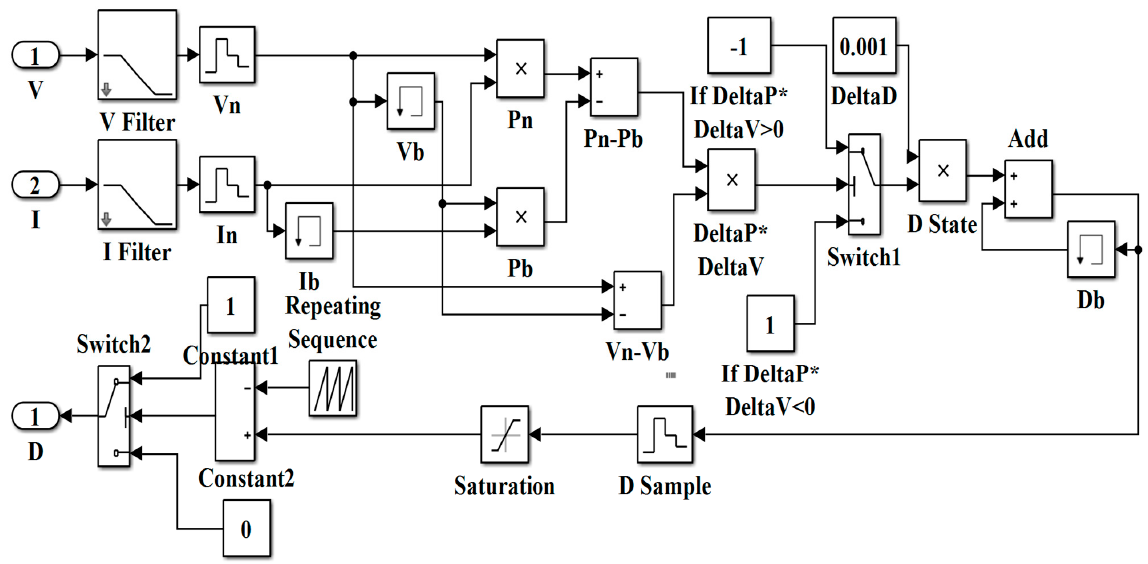
Figure 21. Subsystem of P&O-based control method.